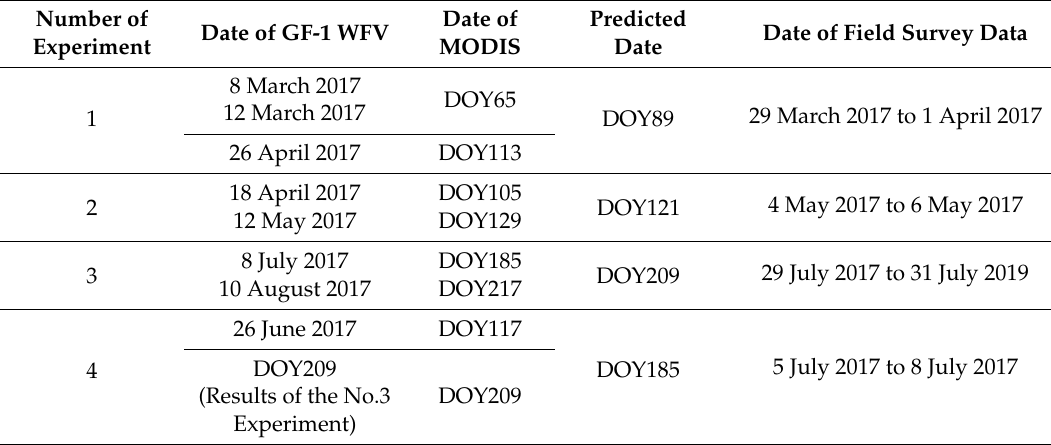
Table 6. Information of the experimental data selected.